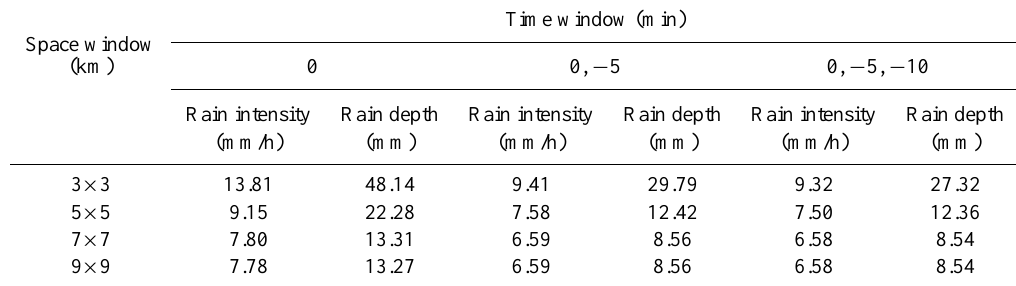
Table 5. Mean absolute error (MAE) in rainfall intensity and rainfall depth for different WCMM scenarios.